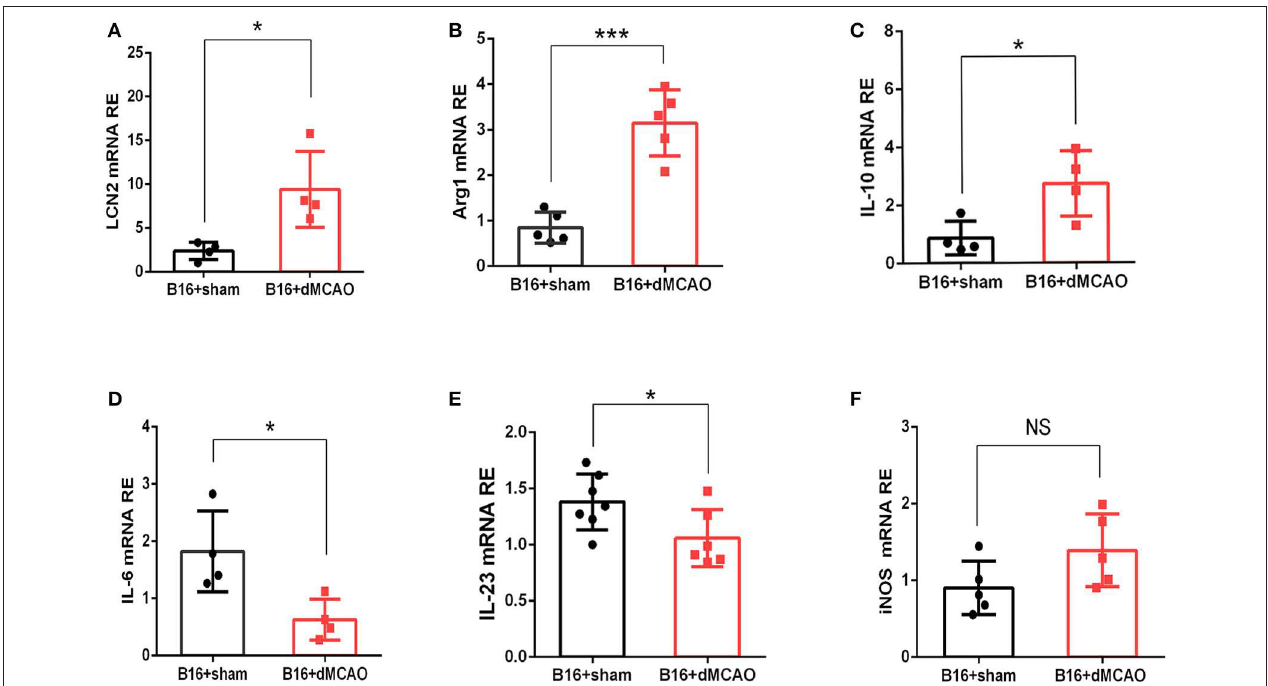
FIGURE 3 | Stroke induces increased mRNA expression of LCN2 and anti-inflammatory Arginase1, and IL-10 in the tumor. (A–C) The mRNA expression of LCN, Arg1, and IL-10 (A–C) was increased in the tumor 3 days after stroke ( n = 4–6, P ≤ 0.05). (D,E) The mRNA expression of IL-6 and IL-23 was decreased in the tumor from cancer stroke mice compared with cancer sham mice ( n = 4–6, P ≤ 0.05). (F) The mRNA expression level of iNOS remained not significantly changed after stroke in cancer mice ( n = 4–6, * P ≤ 0.05, *** P ≤ 0.001, two-tailed Student’s t -test). Data are presented as the mean ± SD. LCN2, Lipocalin 2; Arg1, Arginase 1; iNOS, Inducible nitric oxide